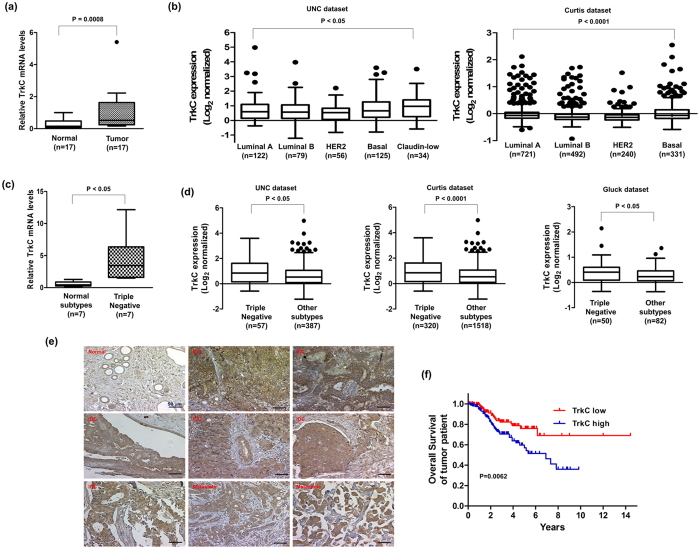
Increased expression of TrkC in human breast carcinomas.(a) Relative levels of TrkC expression in normal or invasive breast carcinoma samples of 17 individual breast cancer patients. The expression was compared to that of healthy tissue, and the endogenous 18S mRNA level was measured as an internal control. A P value was considered to be significant in t-test. (b) The gene expression data were plotted as Box-and-whisker (Tukey) plots of mean TrkC expression levels in molecular subtypes of breast cancer patients. The signatures of TrkC level extracted from 2,136 Curtis and 473 UNC datasets and averaged for each tumor. Points below and above the whiskers are drawn as individual dots. A P value was considered to be significant in ANOVA. (c) Relative TrkC mRNA expression in seven individual normal human tissues or triple-negative breast carcinoma samples. The endogenous 18S mRNA level was measured as an internal control. A P value was considered to be significant in t-test. (d) The mean TrkC expression in other subtypes or triple-negative subtypes of human breast cancer patients from three publicly available data sets (Curtis, Gluck, and UNC datasets). The TrkC gene expression level was extracted from the dataset and averaged for each tumor. Points below and above the whiskers are drawn as individual dots. A P value was considered to be significant in t-test. (e) Pattern of TrkC expression in a series of 59 breast cancer samples. Representative immunohistochemical images of TrkC staining in normal human breast tissue, infiltrating duct carcinoma, and metastatic carcinoma in the lymph nodes (magnification: 200×). (f) Patients were divided into those who expressed high and low TrkB levels, and their survival rates from a publicly available data set (UNC) were compared. The P value was calculated by a log-rank test.